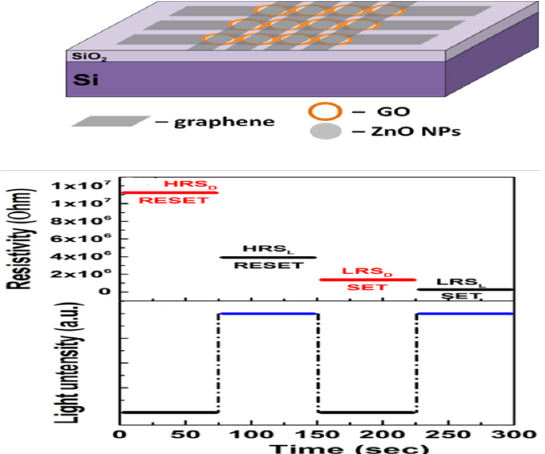
Figure 4. Schematic diagram of a graphene/GO-based photomemristor matrix on a Si/SiO 2 substrate, formed by photocatalytic oxidation in the regions near ZnO nanoparticles (ZnO NPs) and a switching diagram (SET, RESET) of high-resistive (HRS) and low-resistive (LRS) states in the dark (HRS D , LRS D ) and with photoexcitation (HRS L , LRS L ) [20].